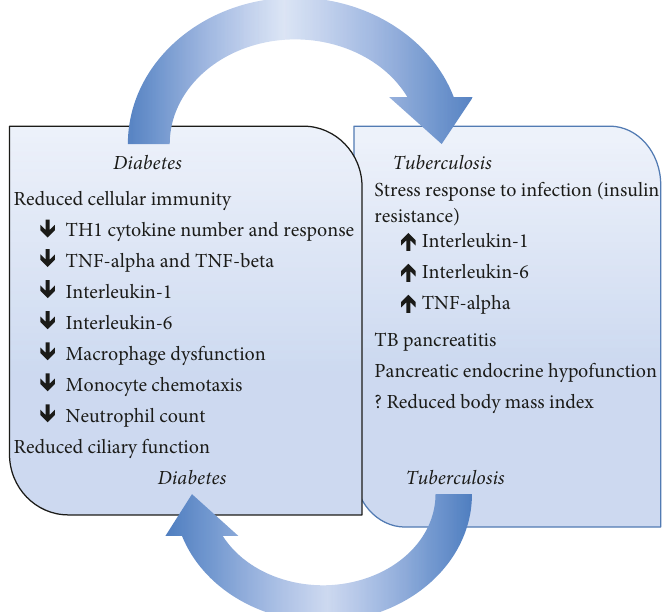
Figure 1: Pathophysiological mechanisms underlying TB–diabetes interaction [3, 18, 28, 29, 31, 35–39]. TH1: T-helper 1; TNF: tumor necrosis factor; TB: